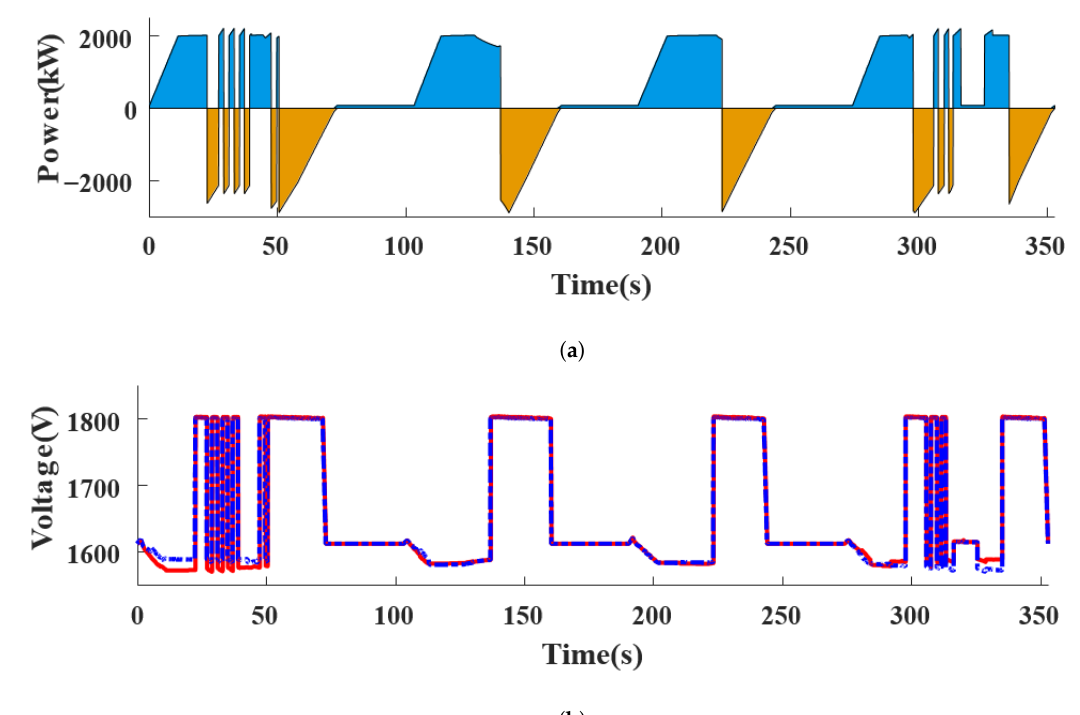
Figure 11. Train power load and voltages of substation A, B in time. ( a ) Train power load traveling between substation A, B. ( b ) Voltage measured at substation A, B while the train moves.